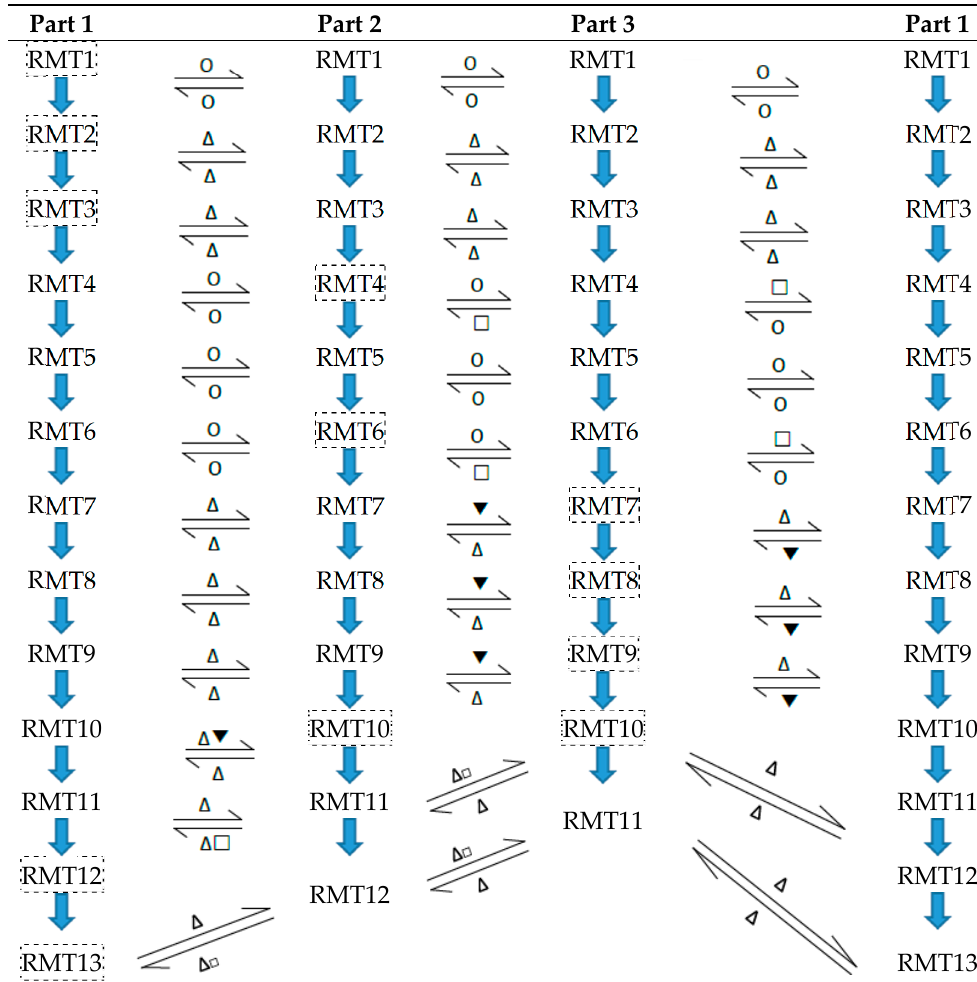
Table 5. Processing conversion of RMTs generated by the three processing plans corresponding to part 1, part 2, and part 3, respectively.